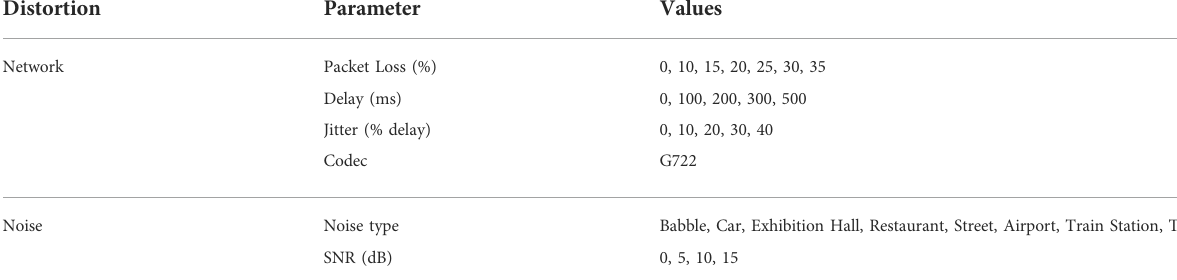
TABLE 1 Noise-network distortion